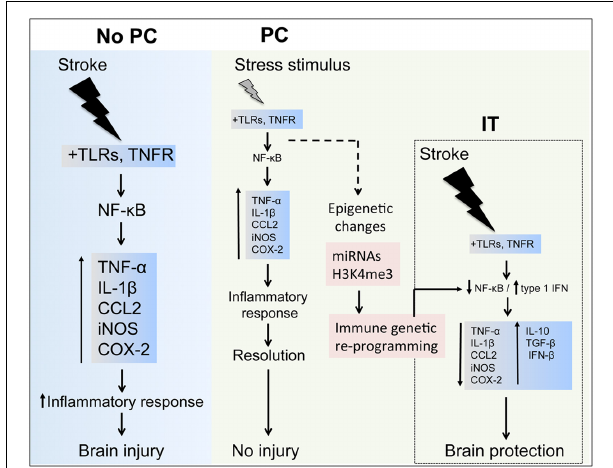
FIGURE 3 | Inflammatory components in stroke and preconditioning. Stroke induces a major inflammatory response through toll-like receptors (TLRs) and tumor necrosis factor receptor (TNFR) signaling, which activate nuclear factor- κ B (NF- κ B) resulting in upregulation of inflammatory molecules, such as TNF- α , interleukin (IL)-1 β , CCL2, inducible nitric oxidase synthase (iNOS) and cyclooxygenase (COX)-2, contributing to the ischemic brain injury. In preconditioning (PC), the exposure to a wide range of stressors activates inflammatory pathways and leads to upregulation of inflammatory molecules similarly to those induced by stroke. After the effects of the stressor have subsided, the inflammatory response is resolved during the early phase of PC and gene expression returns to basal levels. However, longer lasting epigenetic changes induced in the immune system components by micro-RNAs (miRNAs) and histone methylation (i.e., histone H3 trimethylation at lysine 4, H3K4me3) may reprogram inflammatory pathways to respond differently after an episode of severe ischemia, for instance favoring the expression of anti-inflammatory cytokines (IL-10, tumor growth factor-(TGF)- β and interferon-(IFN)- β that induces ischemic tolerance